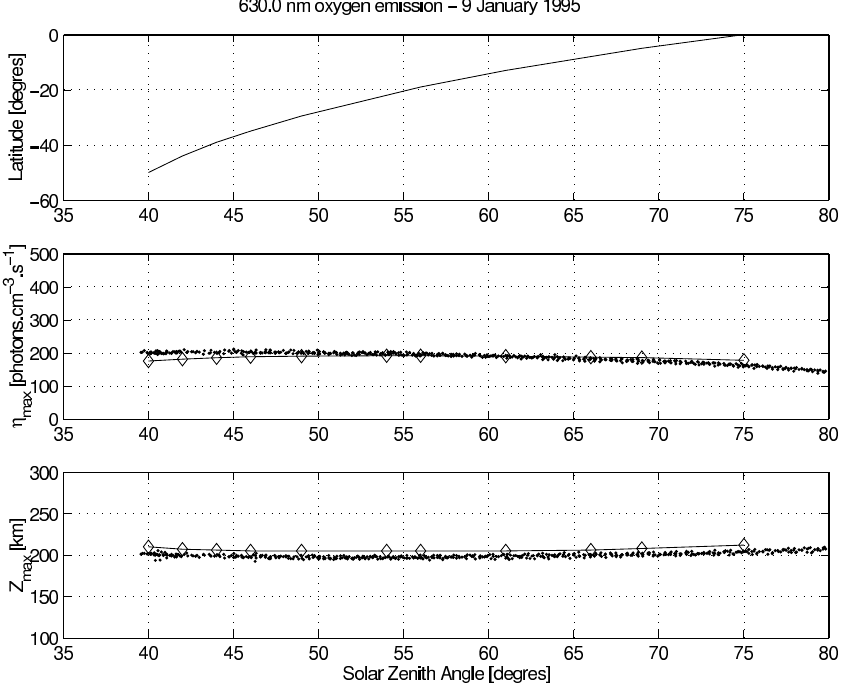
Fig. 8. 630.0nm oxygen line – 9 January 1995 – f 10 . 7 = 73 . 7 ,A p = 7. Dots correspond to WINDII measurements and line/diamonds correspond to TRANSCAR